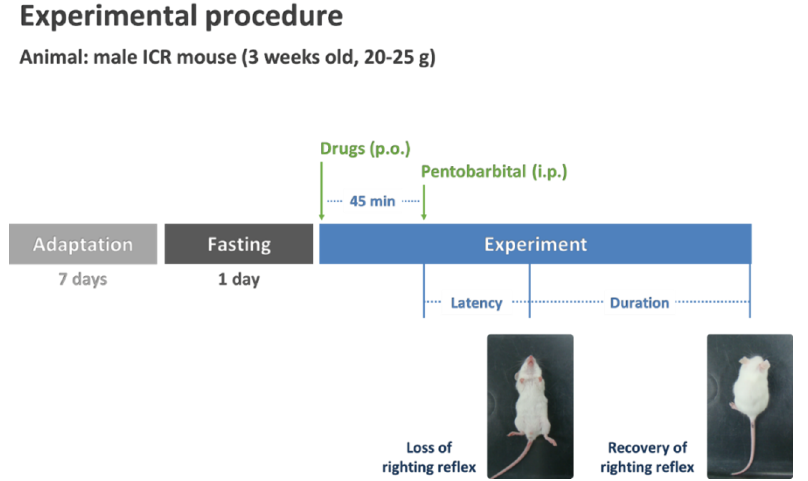
Figure 1. Protocol of pentobarbital-induced sleep test in ICR mice. ICR, imprinting control region; i .p., intraperitoneal injection; p.o., per os